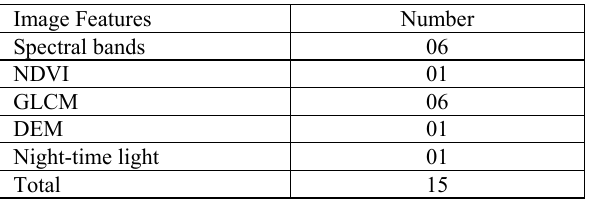
Table 4. Extracted image